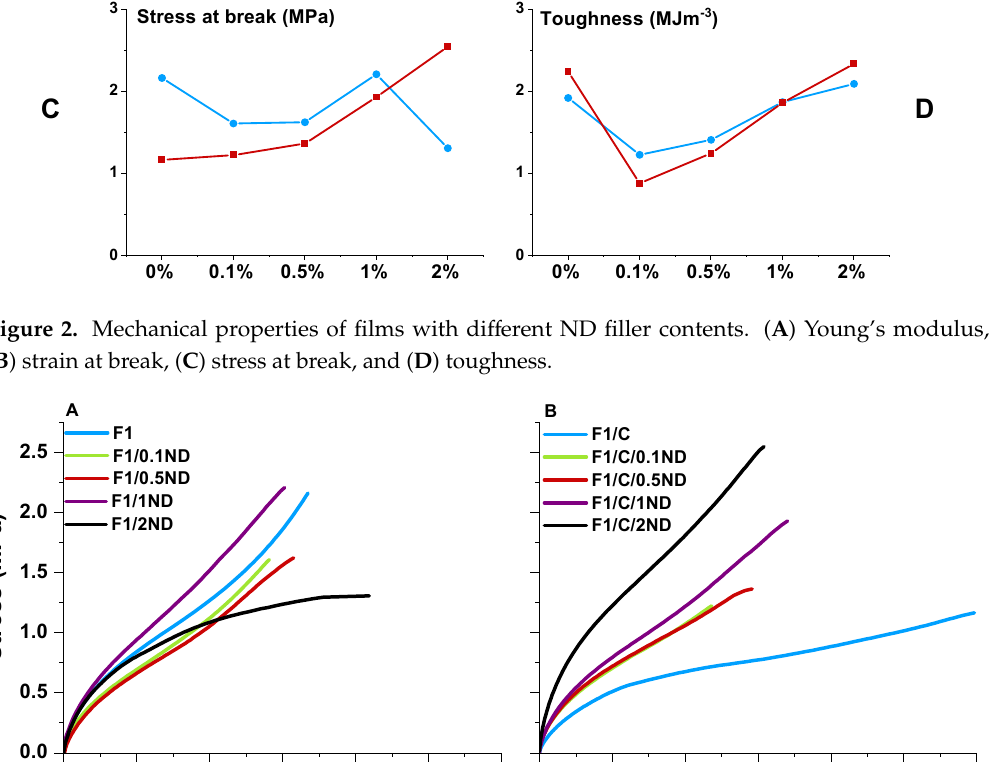
Figure 3. Stress–strain curves of films with an ( A ) ND filler and with an ( B ) ND and complexing agent.